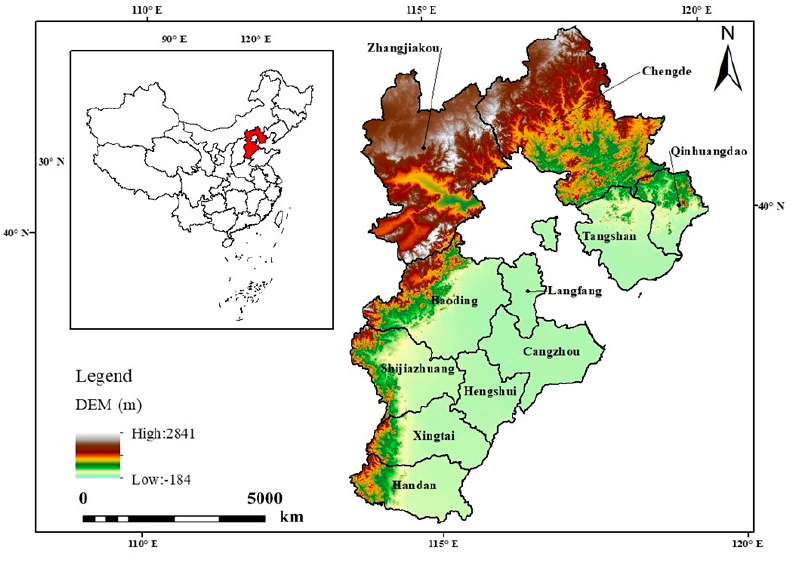
Figure 1. Location of the study area in China.